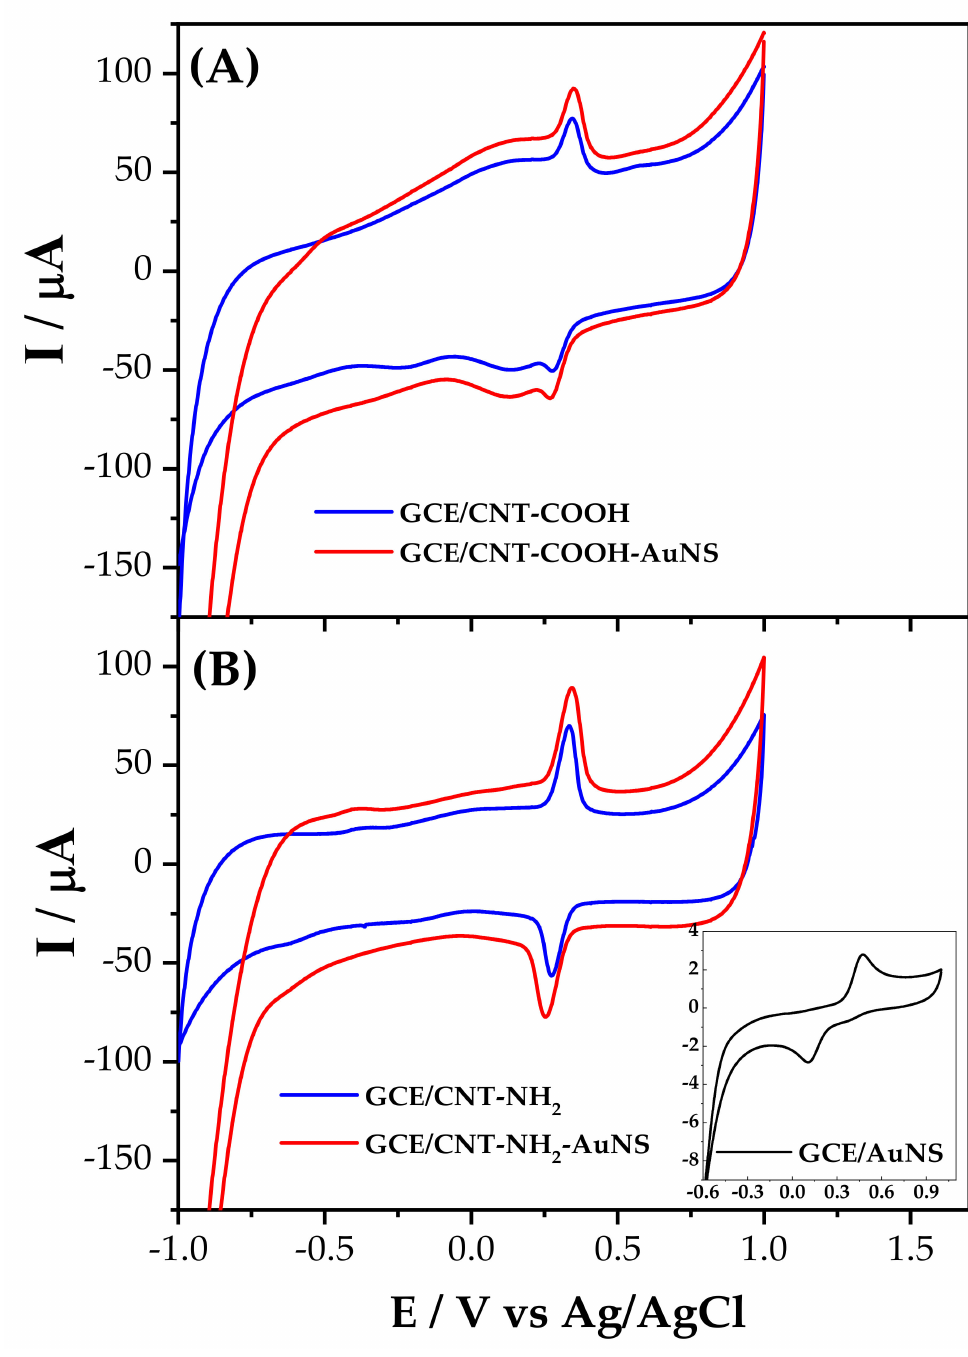
Figure 4. Cyclic voltammograms in the presence of 0.1 mM HQ using the different systems of MWCNT and AuNP. ( A ) MWCNT-COOH (Inset: Cyclic Voltammogram of AuNP modified GCE) with an accumulation time of 180 s, ( B ) MWCNT-NH 2 with an accumulation time of 30 s. Experimen- tal conditions: electrolyte buffer Britton–Robinson 0.1 M, pH 2.0 and scan rate 50 mV s − 1